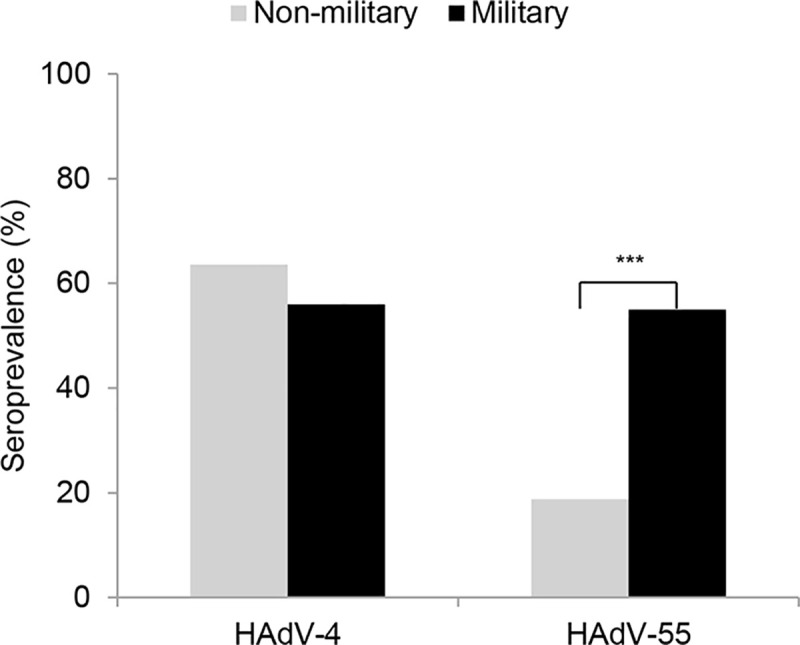
Seroprevalence of neutralization antibodies against HAdV-55 and HAdV-4 in Korean society according to recent military exposure.The data were analyzed with chi-square test. ***P<0.001.